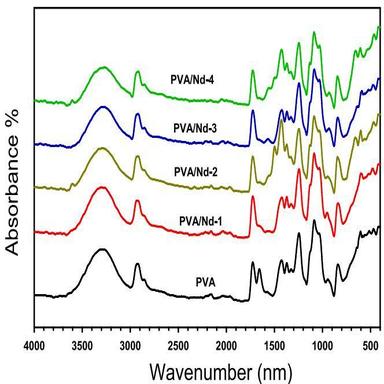
FTIR for the polymer PVA and the composite PVA/Nd2O3.